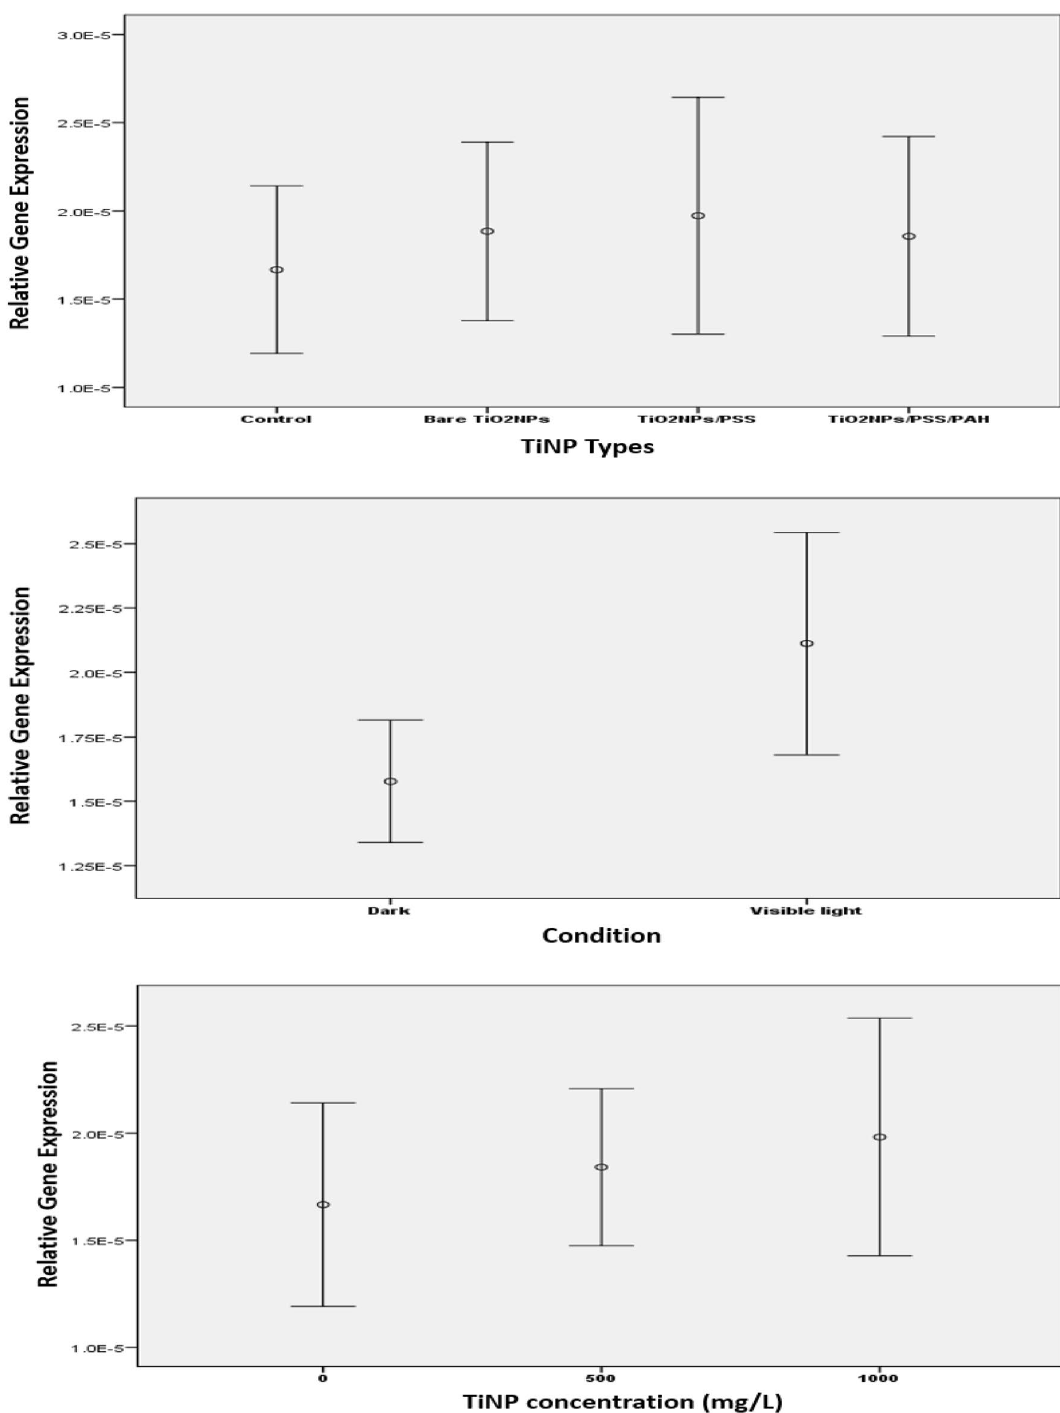
n = 10) following exposure to TiO NPs with various coatings, con- 2 centrations and dark/light